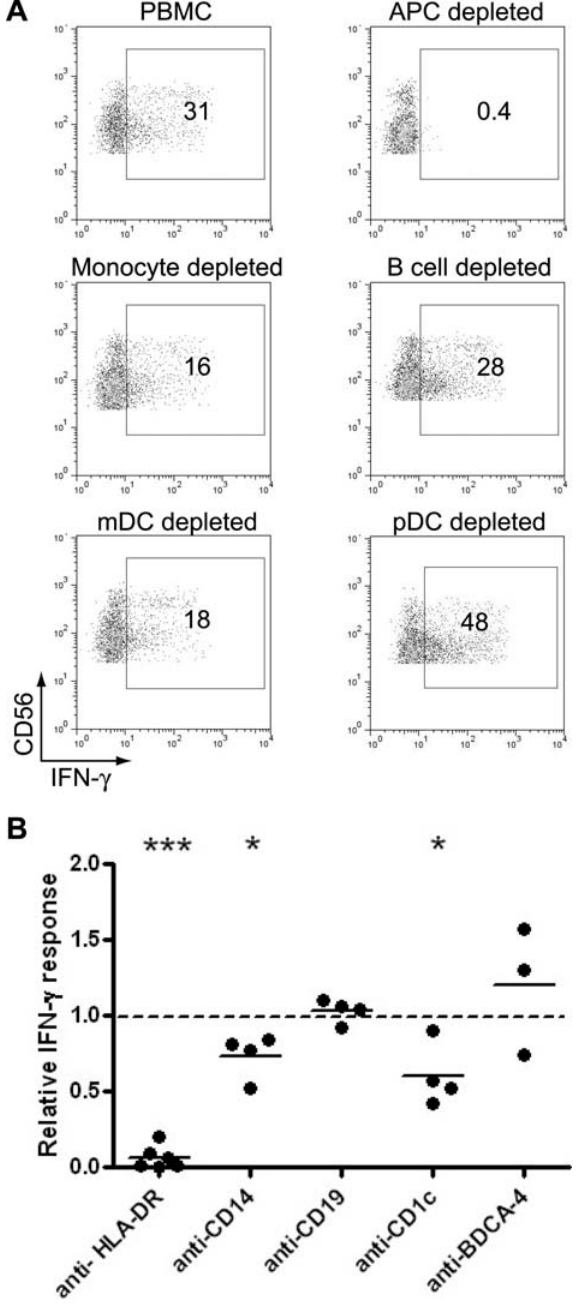
Figure 2. HLA-DR þ Accessory Cells Provide Activating Signals to NK Cells PBMCs from malaria-naı¨ve donors were depleted of different populations of accessory cells, and NK cell responses to iRBCs were analysed after 24 h of co-culture. (A) Representative example of NK cell IFN- c responses in undepleted PBMCs (top left), PBMCs depleted of all HLA-DR þ antigen-presenting cells (APC) (top right), CD14 þ monocyte–depleted PBMCs (middle left), CD19 þ B cell–depleted PBMCs (middle right), CD1c þ mDC–depleted PBMCs (bottom left), and BDCA-4 þ pDC–depleted PBMCs (bottom right). FACS plots are gated on CD3 (cid:1) CD56 þ lymphocytes. Percentages indicate the proportion of CD3 (cid:1) CD56 þ NK cells that were positive for IFN- c ; data are based on the collection of 100,000 total events. (B) NK cell IFN- c production after depletion of different antigen- presenting cell populations. Percentage of IFN- c NK cells relative to the response in undepleted PBMCs is shown; each spot represents data for a different donor. *, p , 0.05; ***, p , 0.0001; p– values are for paired t tests of the difference between depleted and undepleted cells: